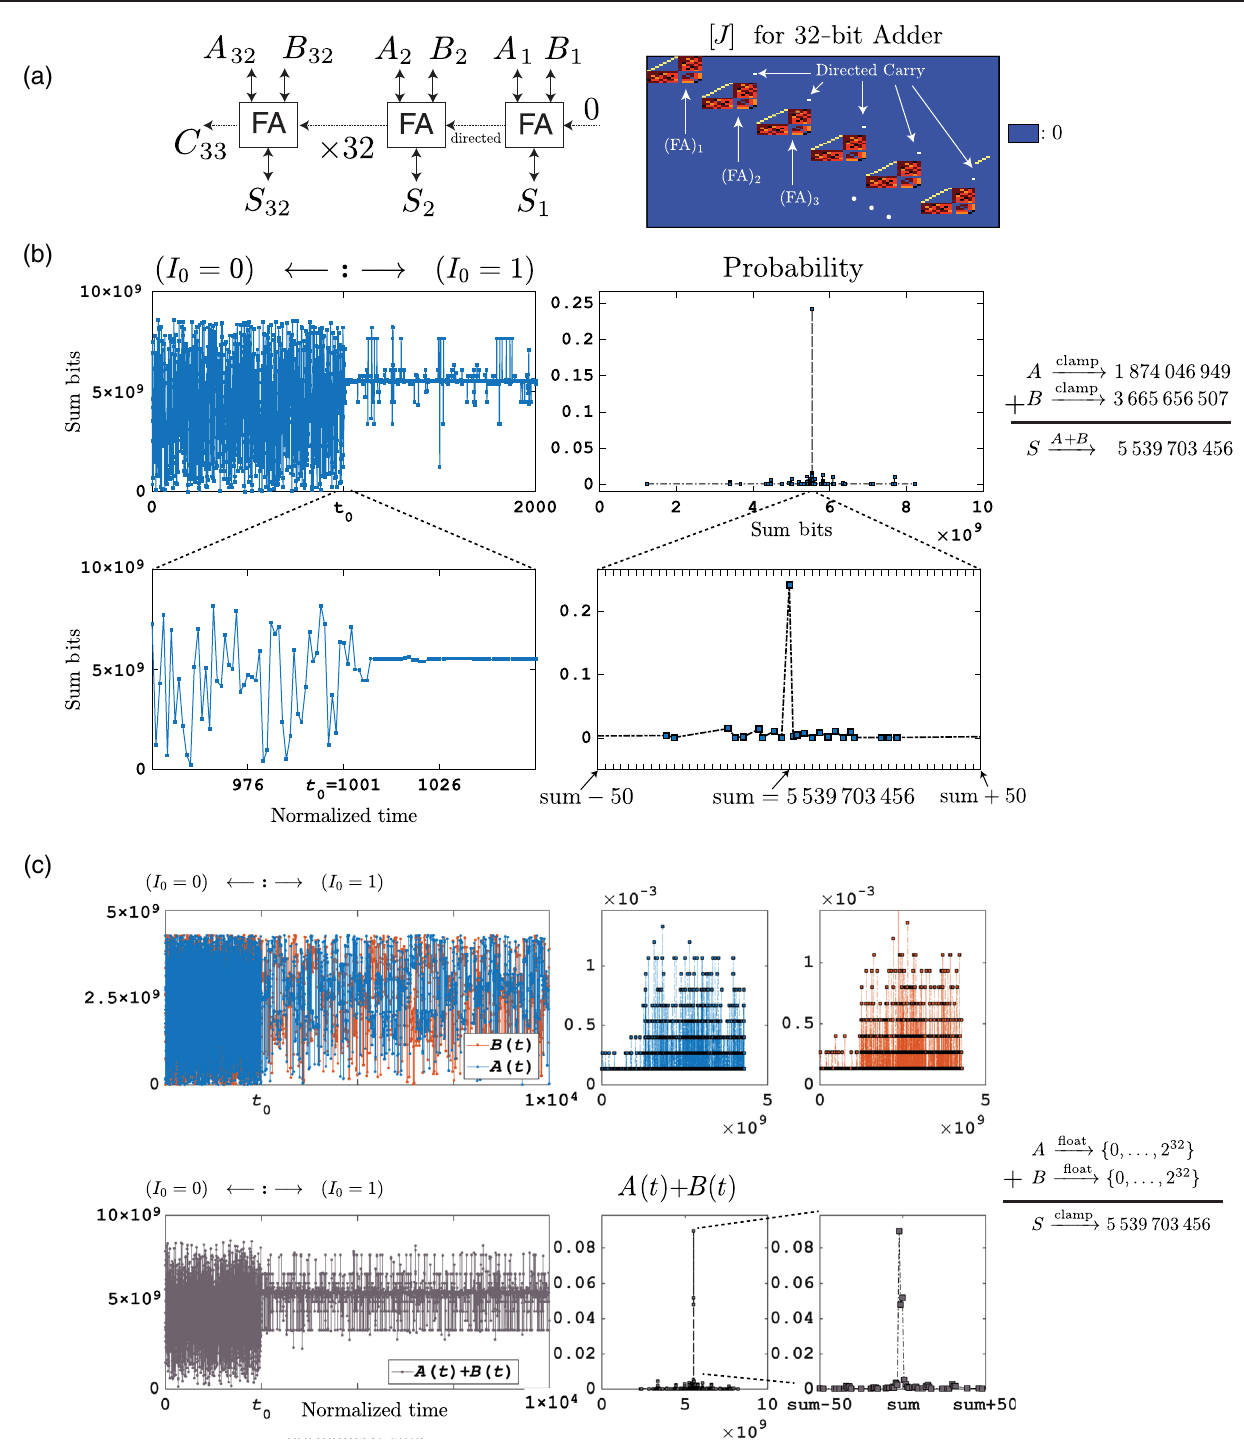
FIG. 11. 32-bit ripple carry adder (RCA). (a) 32-bit ripple carry adder is designed using individual full adder units with the carry bit designed as a directed connection from the least significant bit to the most significant bit. The overall J matrix for a 32-bit adder J matrix is shown, and it is quite sparse and quantized. (b) For t < t 0 , I 0 ¼ 0 and the sum fluctuates randomly. At t ¼ t 0 , I 0 is suddenly increased, and the adder converges on the correct result for two random inputs A and B . The distribution of 1000 data points ( t > t 0 ) shows a single peak with 24% probability of time spent in the correct state (not including the uncorrelated time points for t < t 0 ). (c) Even though the connections between the full adder units are directed, the system performs the inverse function as well. When the output ( S ) is clamped to a fixed number, the inputs ( A ) and ( B ) fluctuate in a correlated manner to make A þ B ¼ S when I 0 ¼ 1 . Note the broad distributions of A and B (collected for t > t 0 ) as compared to the extremely sharp distribution of A þ B